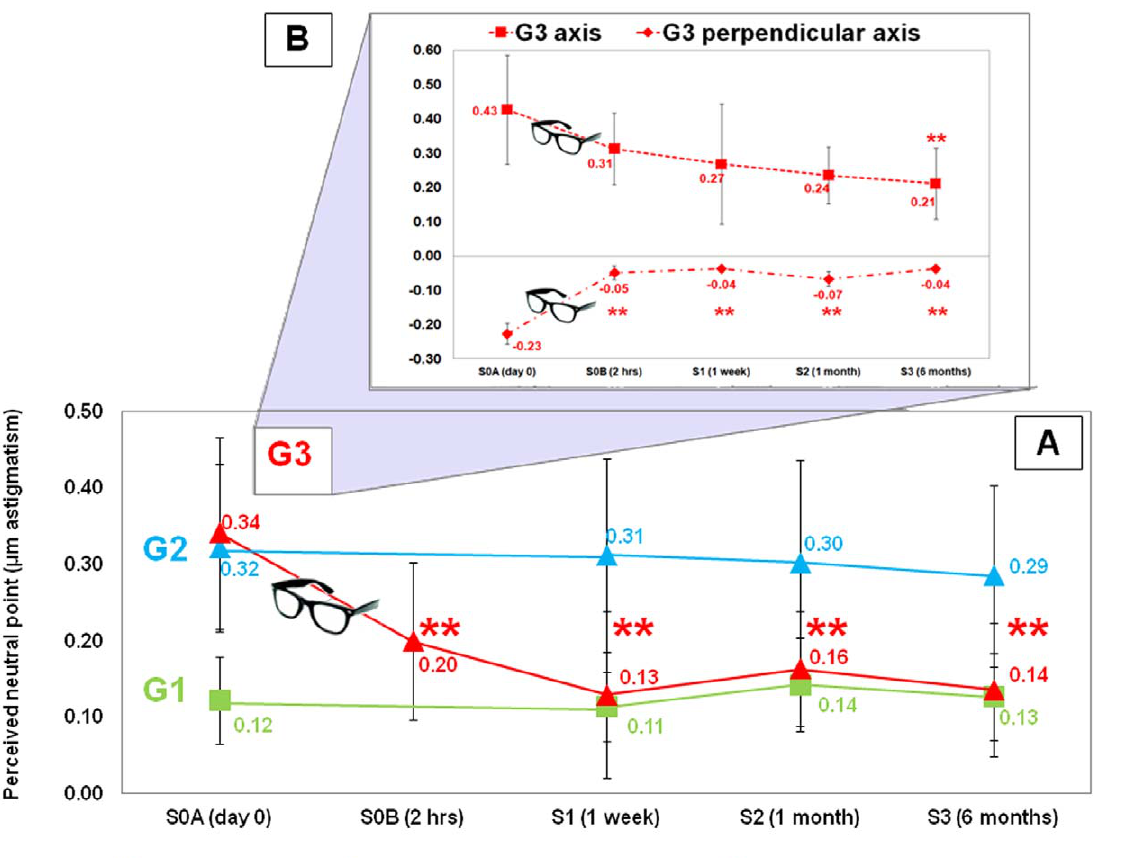
Figure 4. Longitudinal variations in the perception of neutral point. A. Longitudinal variation of the perceived neutral point ( m m astigmatism, absolute value), averaged across subjects in each group (G1: green squares; G2: blue triangles; G3: red triangles). B. Longitudinal variations of the perceived neutral point ( m m astigmatism) averaged across subjects of the 2 subgroups of G3: G3 axis (4/7 subjects) and G3 perpendicular axis (3/7 subjects). ** indicates statistically significant shifts (p , 0.01), from the first session to other measurement sessions (2 hrs, 1 week, 1 month and 6 months) for G3. Error bars stand for inter-subject variability (standard deviation).